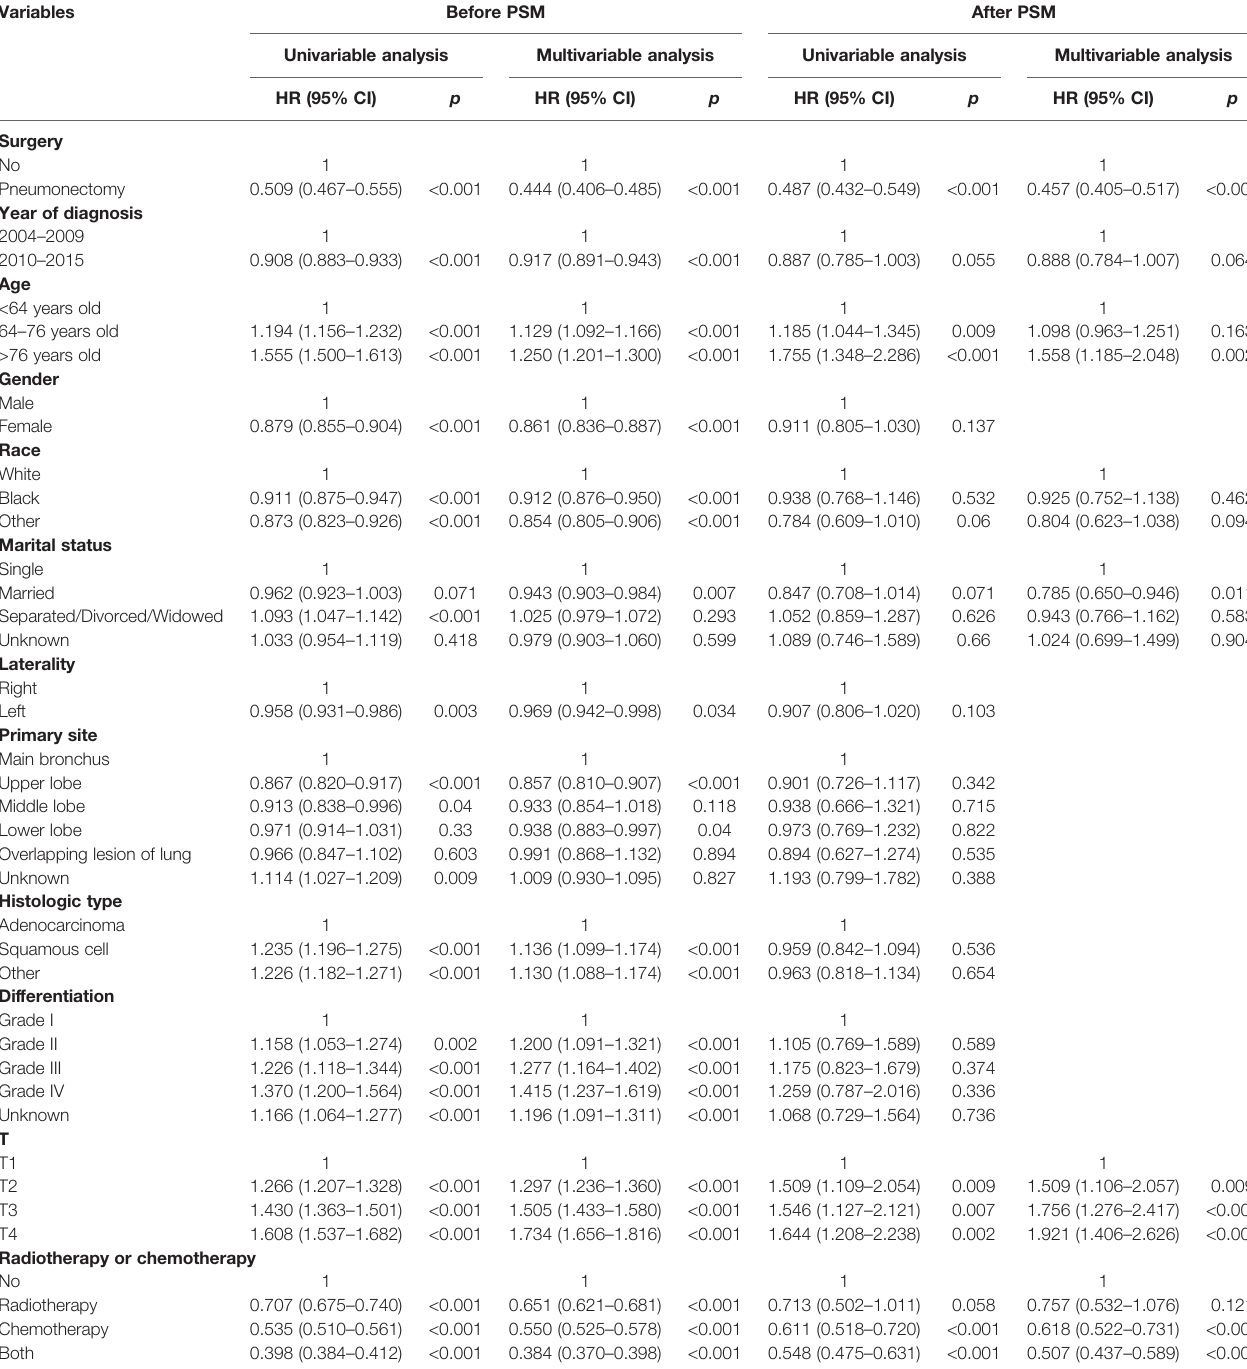
TABLE 3 | Cox regression analysis of the in fl uence of pneumonectomy on CSS in stage T1 – 4N2M0 NSCLC patients.